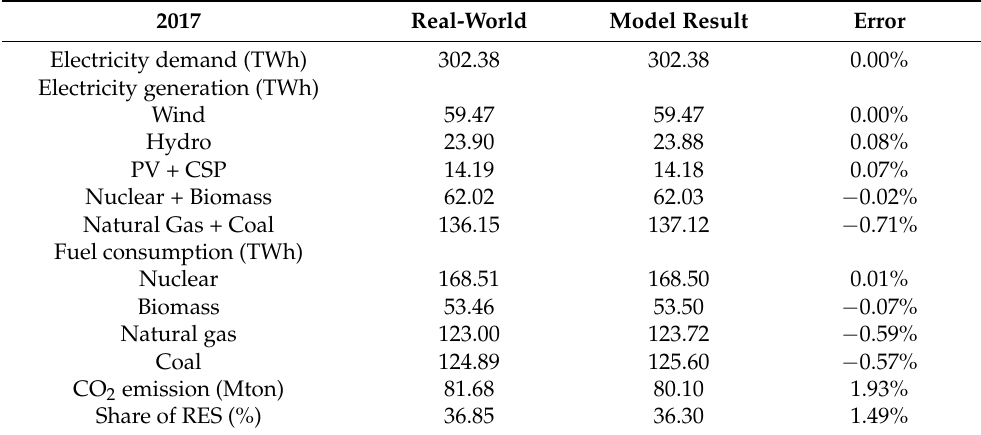
Table 1. Real-world, EnergyPlan model year and error results for 2017 reference